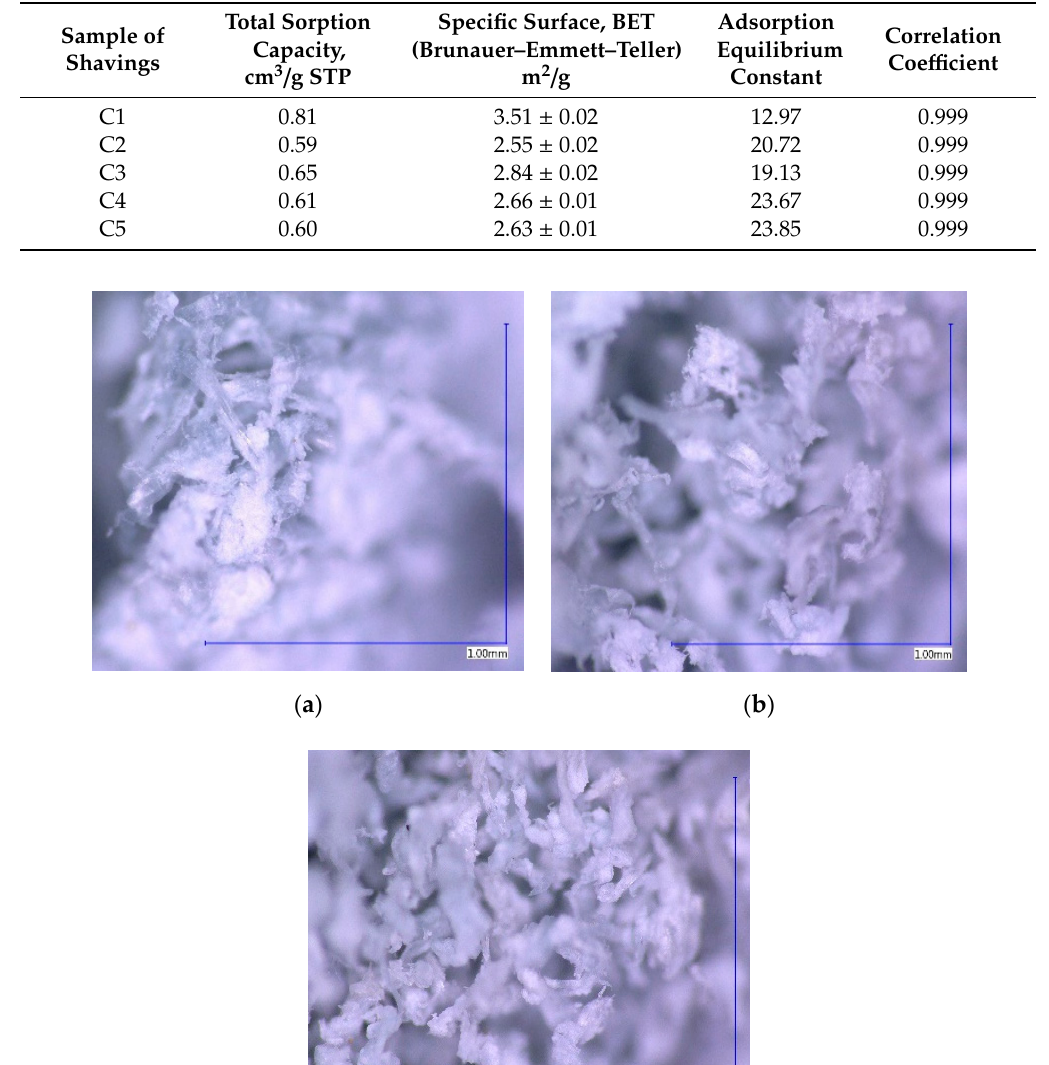
Table 2. Grain-size composition of shavings .